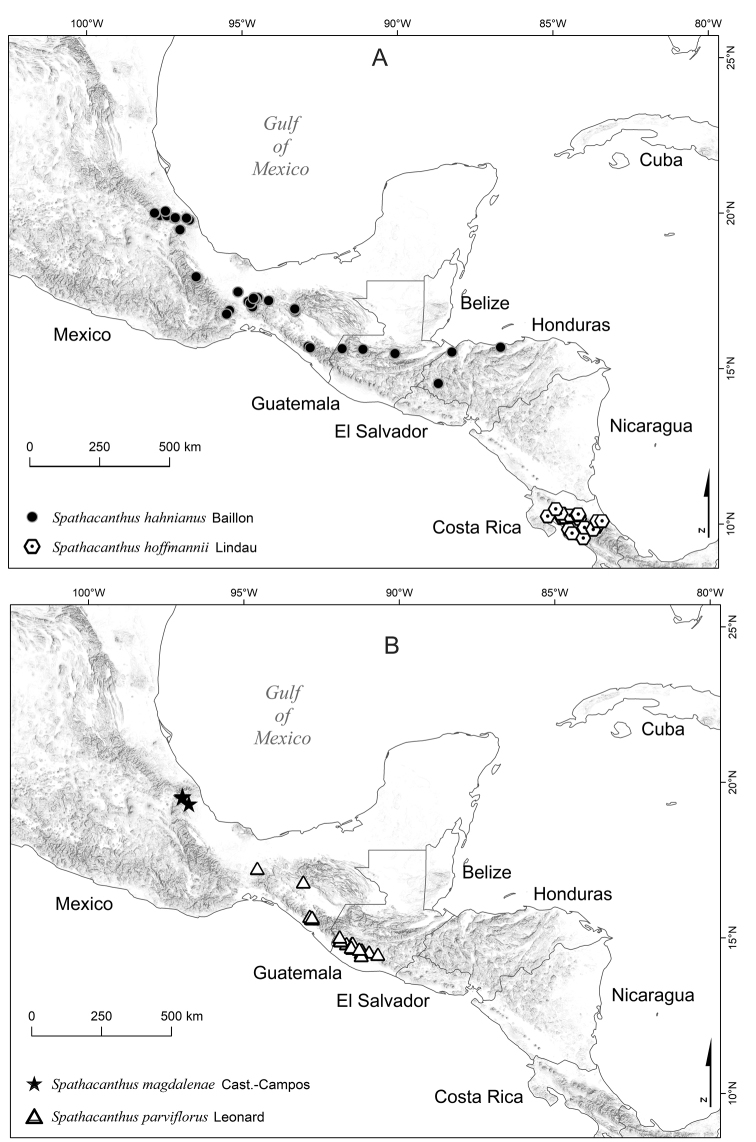
Distribution of the Mesoamerican genus Spathacanthus Baillon. A Distribution of S.
hahnianus and S.
hoffmanniiB distribution of S.
magdalenae and S.
parviflorus.